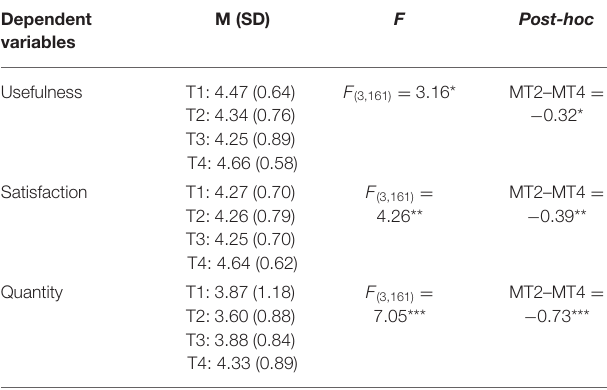
TABLE 2 | One-way ANOVA of the mediating variables according to the time for reflection. Dependent variables